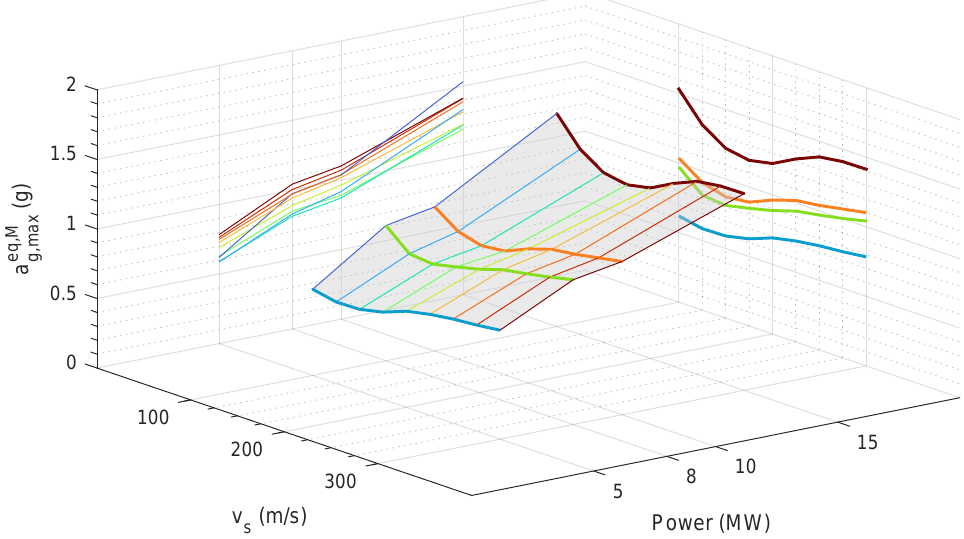
Figure 7. Equivalent ground maximum acceleration for the bending moment at the mudline level. Mean value of the results corresponding to different accelerograms. Influence of soil stiffness and turbine power.